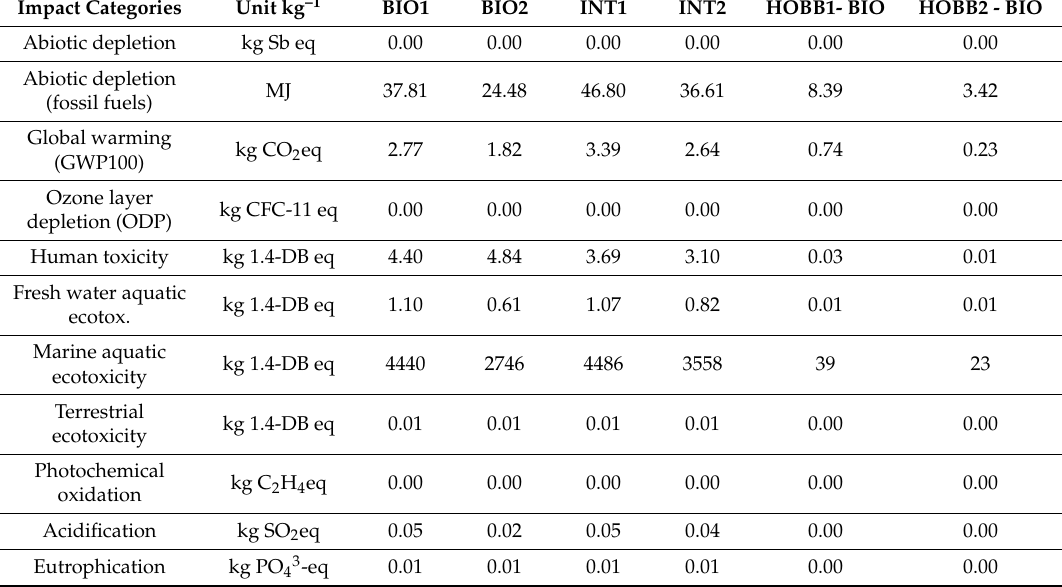
Table 7. Total environmental impacts specified for individual impact categories per liter of olive oil produced by each analyzed